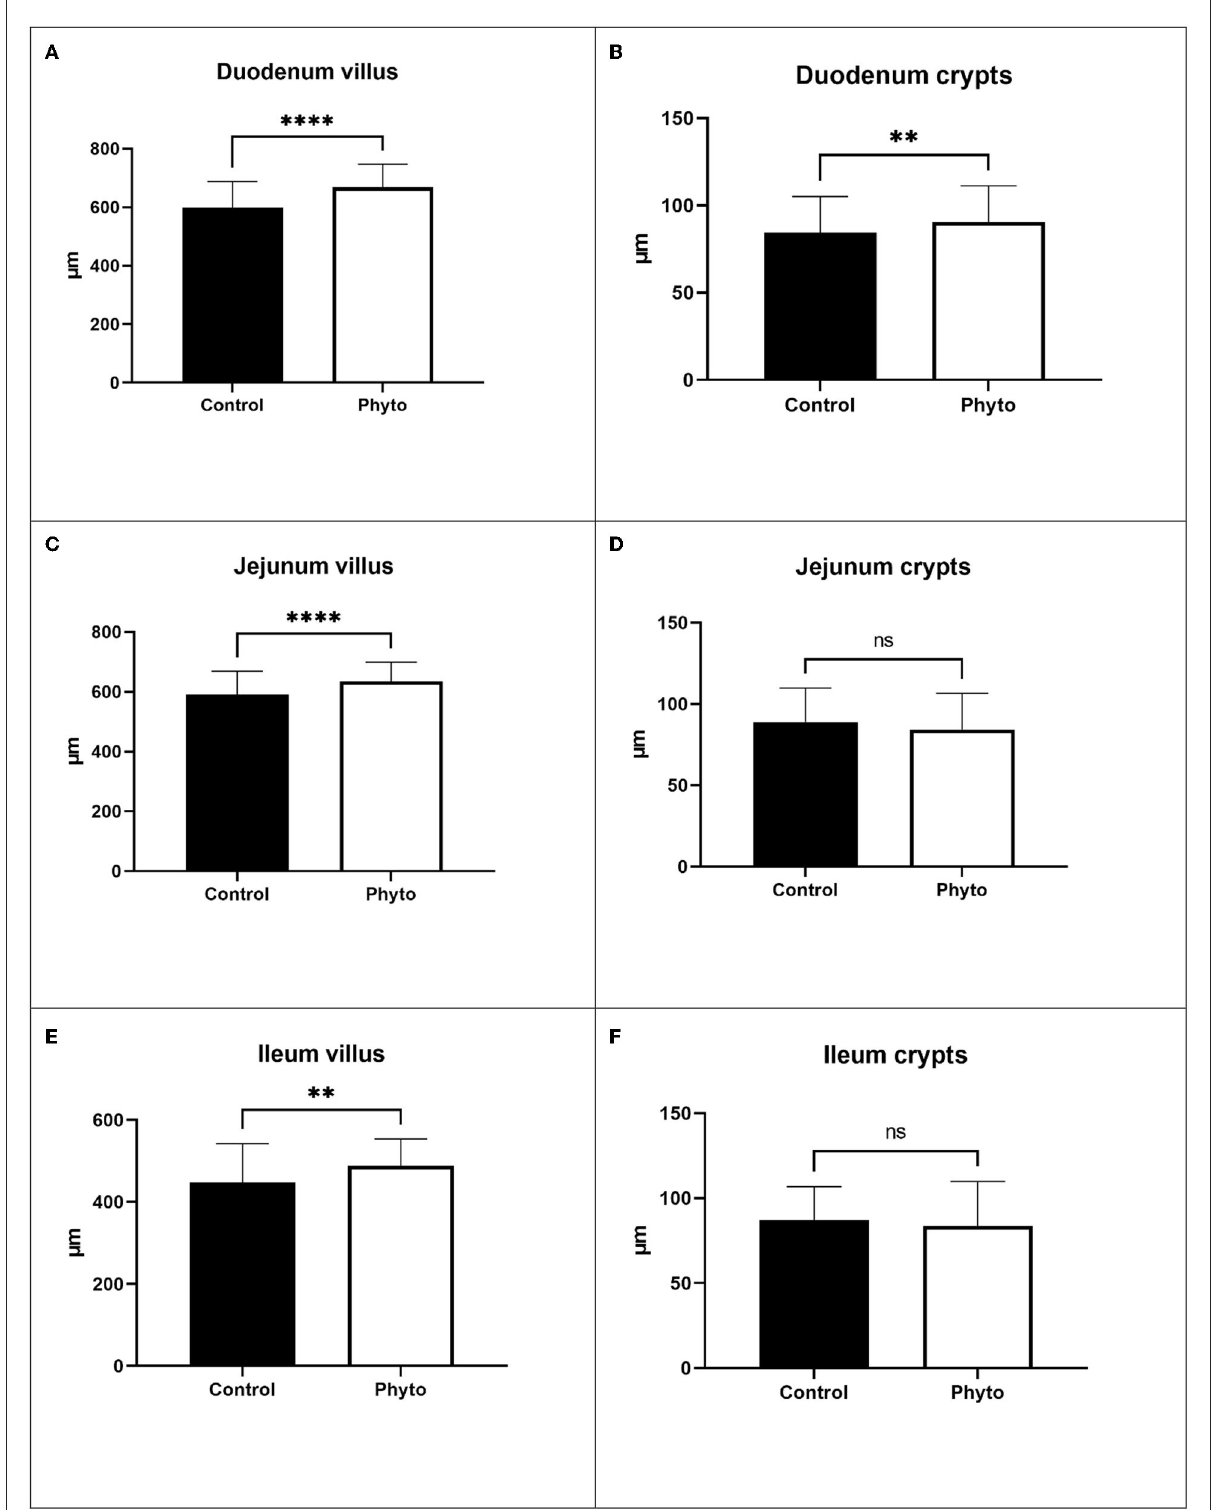
FIGURE4 Effect of dietary supplementation with PHYTO on duodenal, jejunal, and ileal villus height and crypt depth of laying hens at the end of the trial (1 hen per replicate cage; n = 25 per treatment). (A) Duodenum villus; (B) Duodenum crypts; (C) Jejunum villus; (D) Jejunum crypts; (E) Ileum villus; (F) Ileum crypts. Bars represent mean values and error bars standard deviation of values within each experimental group. **** P < 0.0001; ** P < 0.01; ns, not